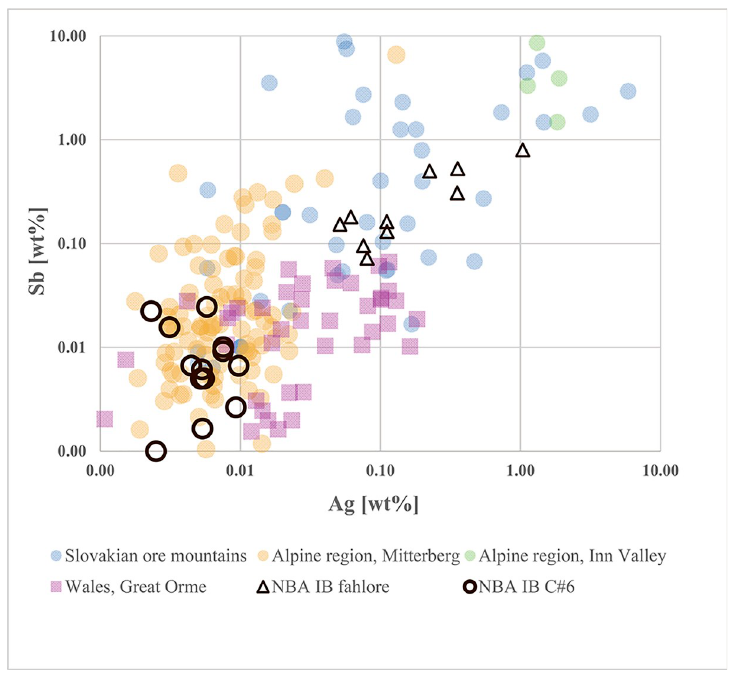
Fig 13. Diagram of Sb/Ag of the NBA IB artefacts consisting of high-impurity copper compared to the low- impurity copper C#6. The Sb/Ag concentration suggests an origin for the fahlore copper in the Slovakian Ore Mountains, while the low-impurity copper is consistent with the tendencies discovered for the shaft-hole axes and point to East Alpine copper. The ore data are from: Mitterberg ore district [35], Hron Valley, Slovakia [27,28],Inn Valley/Buchberg, Alpine region [29,30],Great Orme mining region, Wales [36–39].